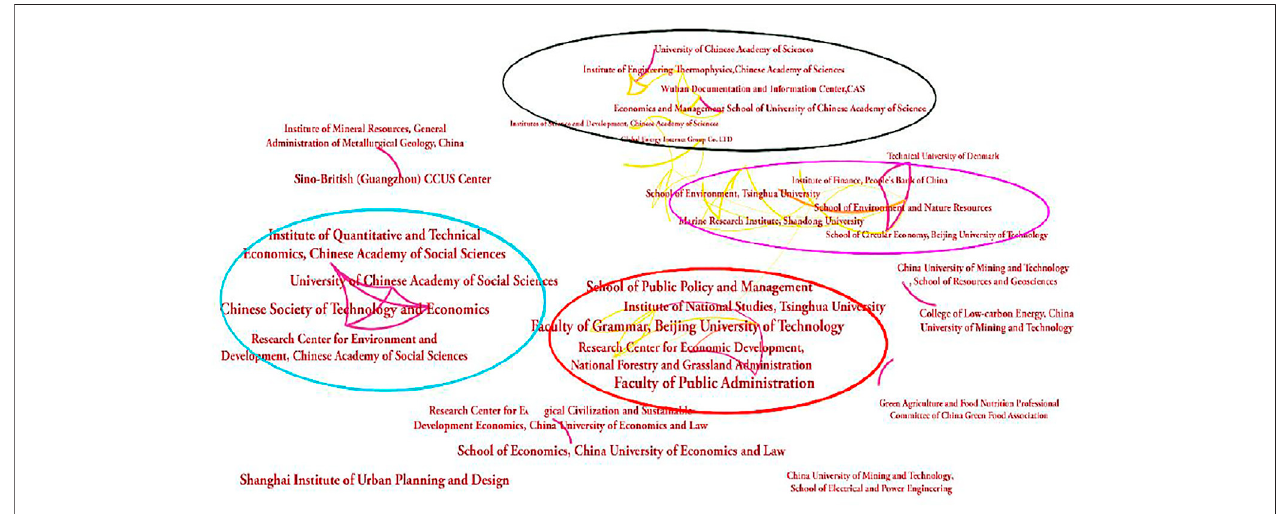
FIGURE 4 | Carbon neutrality research load capacity collaboration network